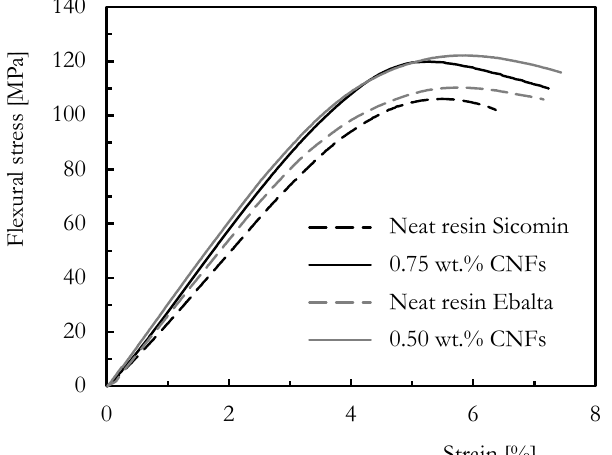
Figure 4: Representative flexural stress-strain curves obtained for 9.7×10 − 2 s − 1 . Comparison between neat and the best nano enhanced